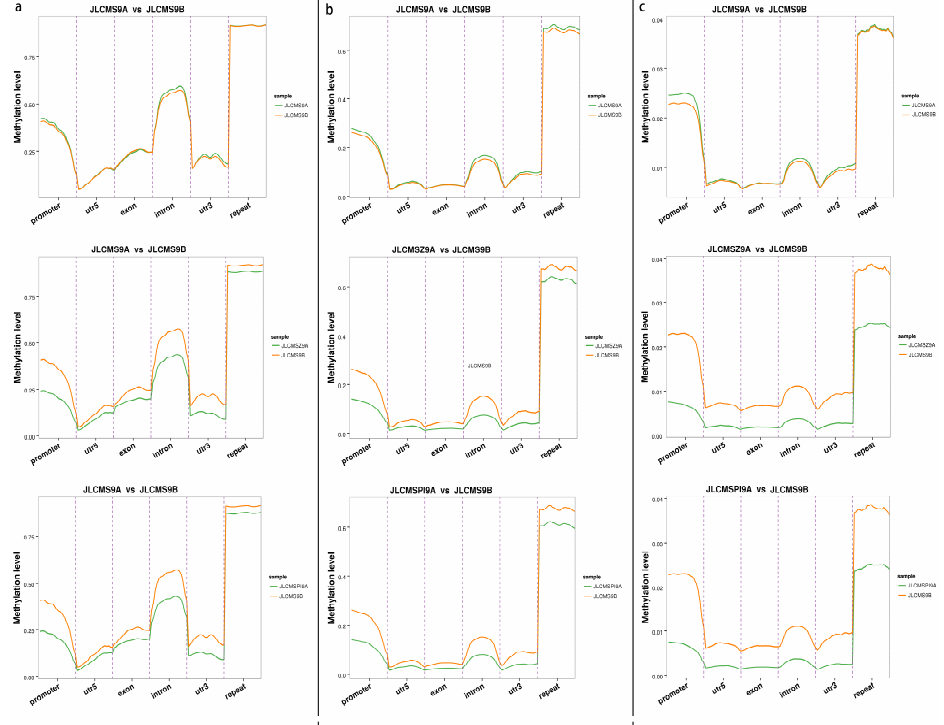
Figure 2. Distribution of methylated cytosines in the different genomic elements among four soybean genomes. The different genomic elements (X-axis), promoter, utr5 (5′-untranslatedregion), exon, intron, utr3 (3′-untranslatedregion), repeat, were divided into 20 bins, and then the methylation levels of all elements were respectively averaged. The methylation levels are shown on the Y-axis. The letter ( a , b , c ) represents sequence contexts mCG/CG, mCHG/CHG, and mCHH/CHH, respectively The correlation coefficients among the four lines were >0.50 (as shown in Figure S1). The results show that JLCMSZ9A and JLCMSPI9A, as well as JLCMS9A and JLCMS9B were closest, with correlation coefficients of >0.88 in the three mC contexts (Figure S1).